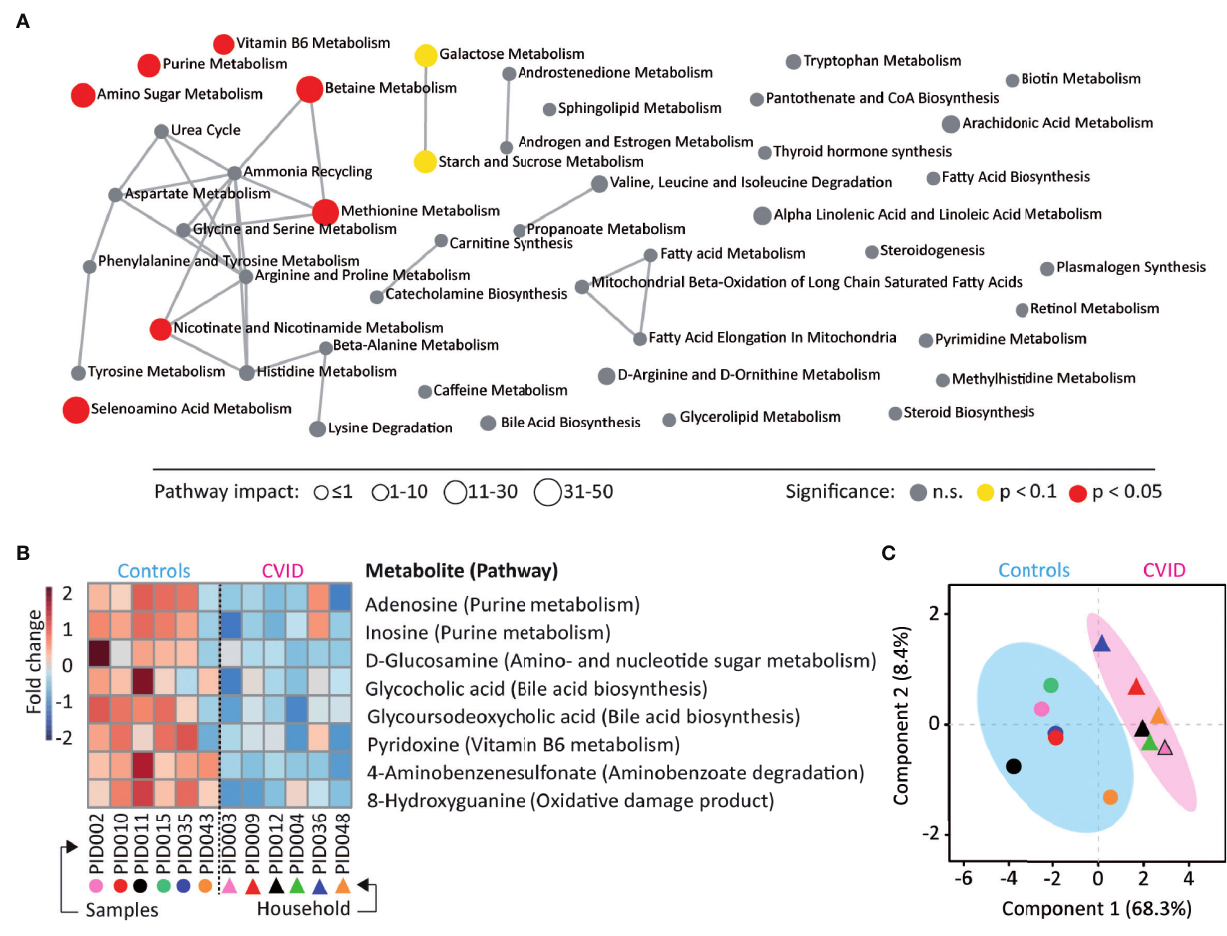
FIGURE 4 | CVID stool metabolome shows differences in purine metabolism. (A) Metabolites identi fi ed in the LC-MS metabolome analysis belonged to 46 metabolic pathways and seven pathways showed dysregulation between CVID and healthy controls (p<0.05, QEA). Symbol size represents the pathway impact, which considers the relative abundance of metabolites in pathways (30, 31). (B) A heat map of eight metabolites signi fi cantly different between CVID and controls (p<0.05, Mann-Whitney). (C) The association of signi fi cant metabolites with diagnosis (R 2 =0.86, PLS-DA). (A – C) The MetaboAnalyst was used for visualizations and statistical calculations. Complete metabolomic analysis is shown in Table S6